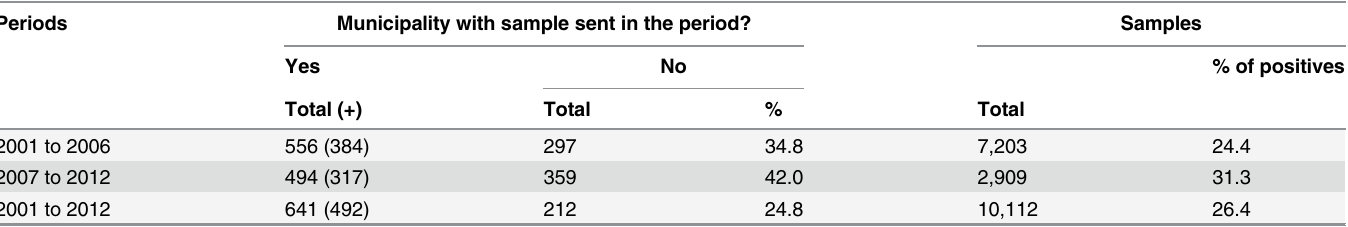
Table 2. Number of municipalities testing animal samples and total number of sent samples in Minas Gerais, Brazil, from 2001 to 2012. Periods